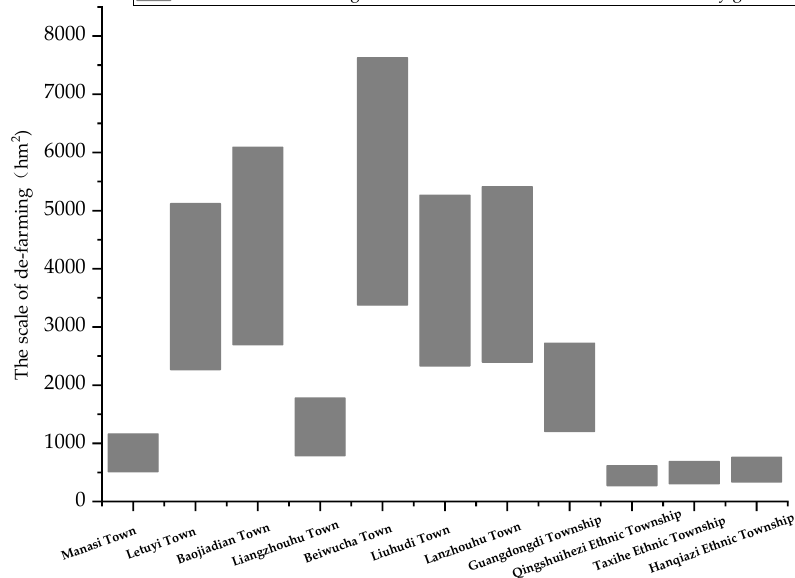
Figure 3. The area of de-farming for water resources limitation and food security guarantee.